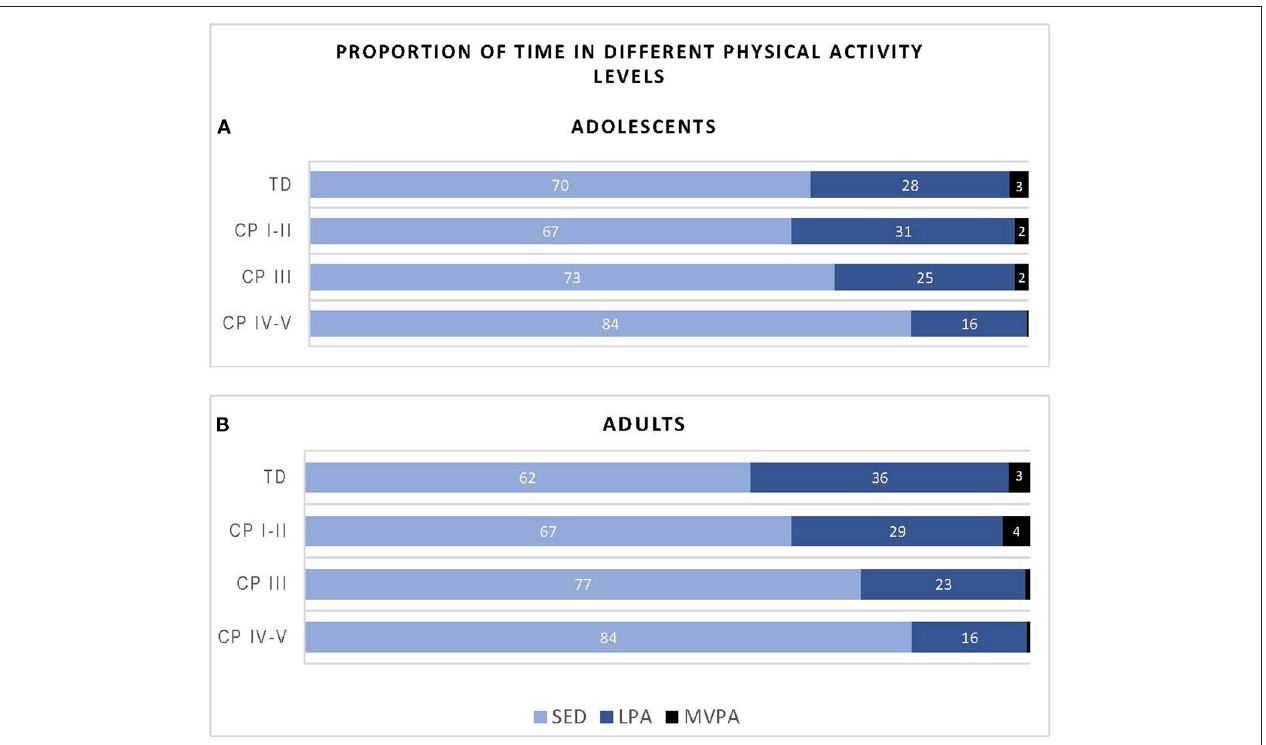
FIGURE 2 | Proportion of time adolescents (A) and adults (B) with cerebral palsy (CP) and typically developing (TD) peers spend in sedentary (SED), low physical activity (LPA) and moderate to vigorous physical activity (MVPA) based on data recorded over the “whole week” using Freedson cut-points. CP groups includes CP I-II, participants with CP classified in Gross Motor Functional Classification System (GMFCS) level I and II; CP III, participants with CP classified in GMFCS level III; CP IV-V, participants with CP classified in GMFCS level IV and